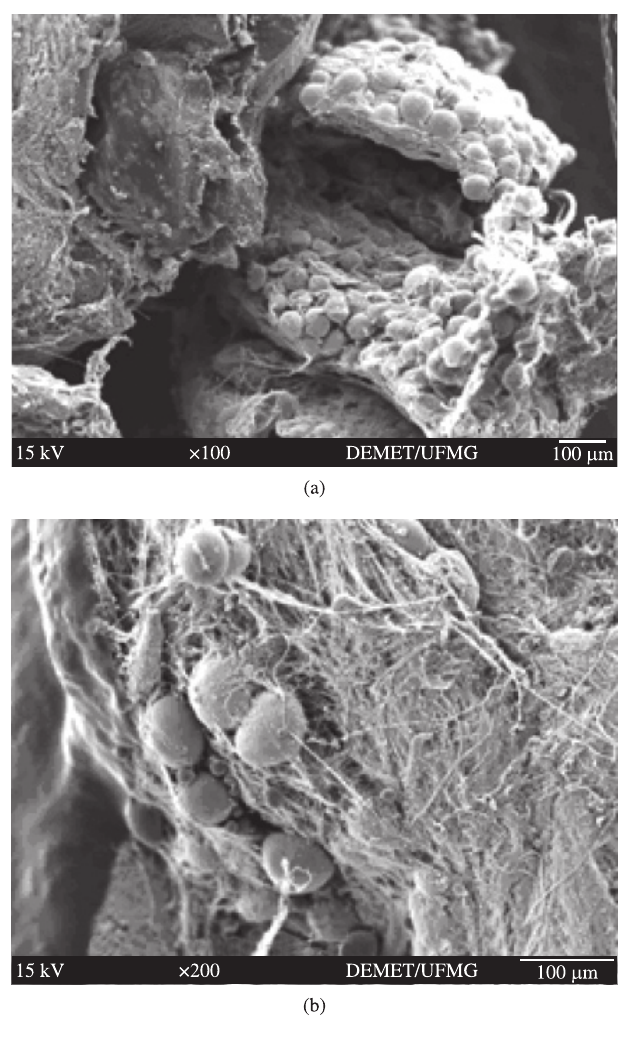
Figure 11. a) SEM image of the nanocomposite internal pores with colonized cells after 21 days of implant. b) SEM image of fibers attached to polyurethane